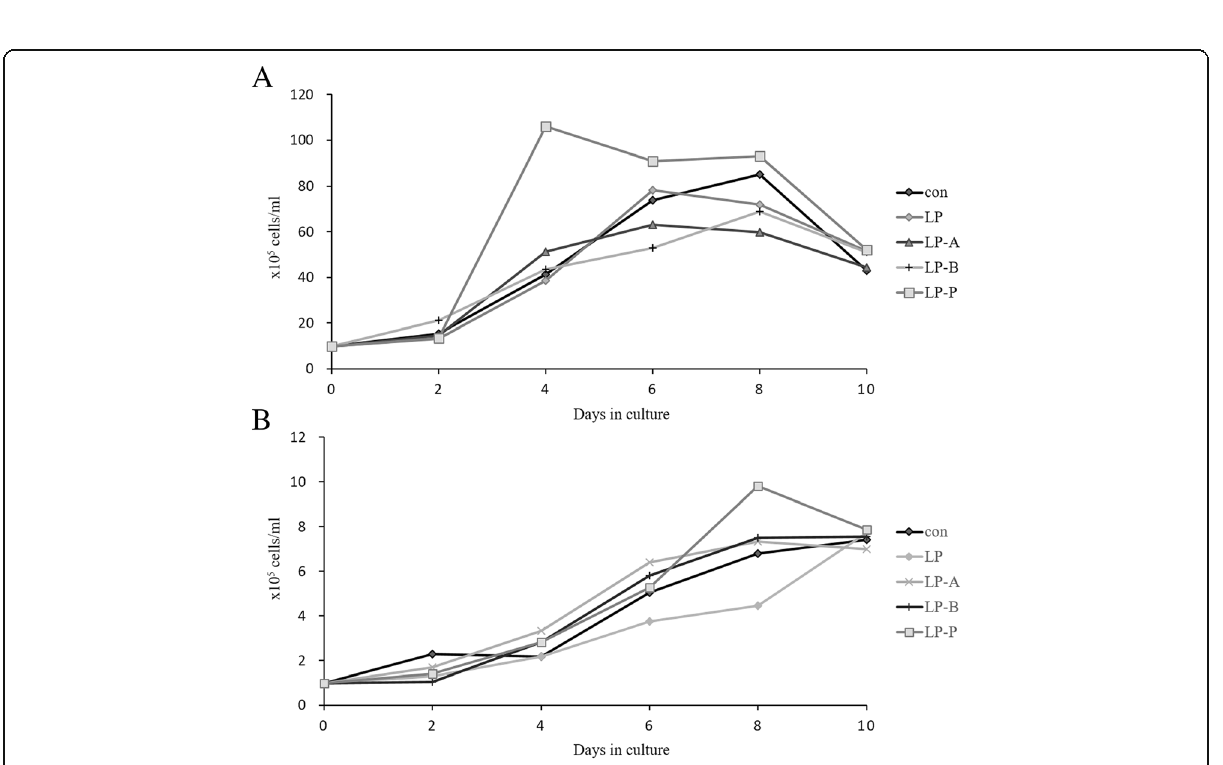
Fig. 2 Growth of a MG-63 cells and b hDPC over 10days. The control (con) group was not a treated sample, hydrolysates of L. plantarum (LP), hydrolysates of L. plantarum by Alcalase (LP-A), hydrolysates of L. plantarum by bromelain (LP-B), and hydrolysates of L. plantarum by Protamex